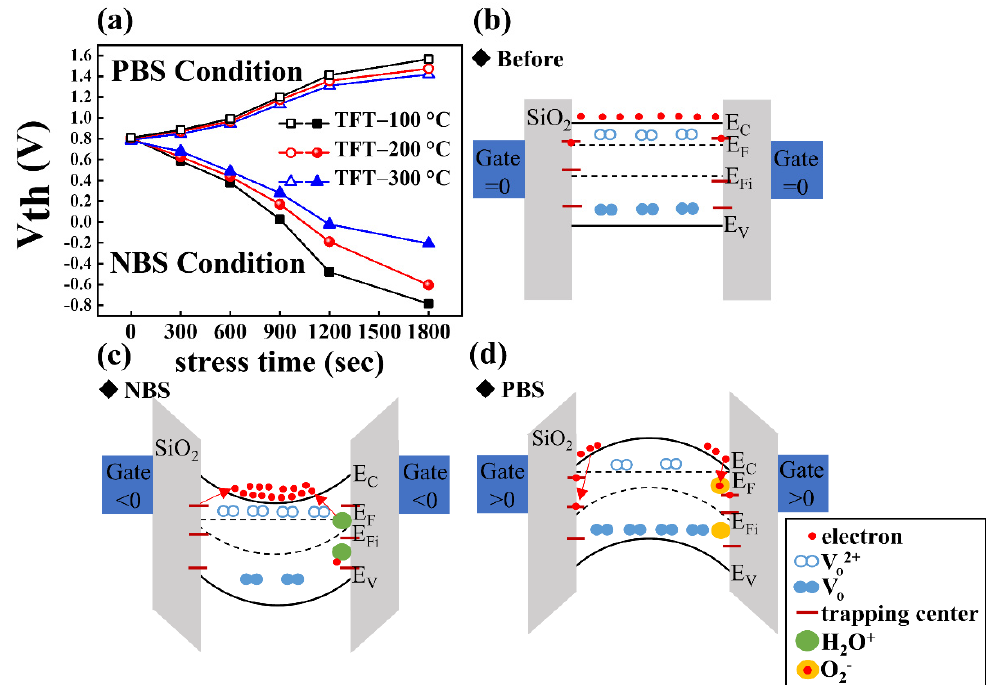
Figure 9. ( a ) The Δ V TH of DG IGZO TFTs with PBS and NBS tests for TFT from the initial condition to the annealed condition at 300 °C. The energy band diagrams for the DG TFTs before and after NBS and PBS tests are shown in ( b – d ), respectively.